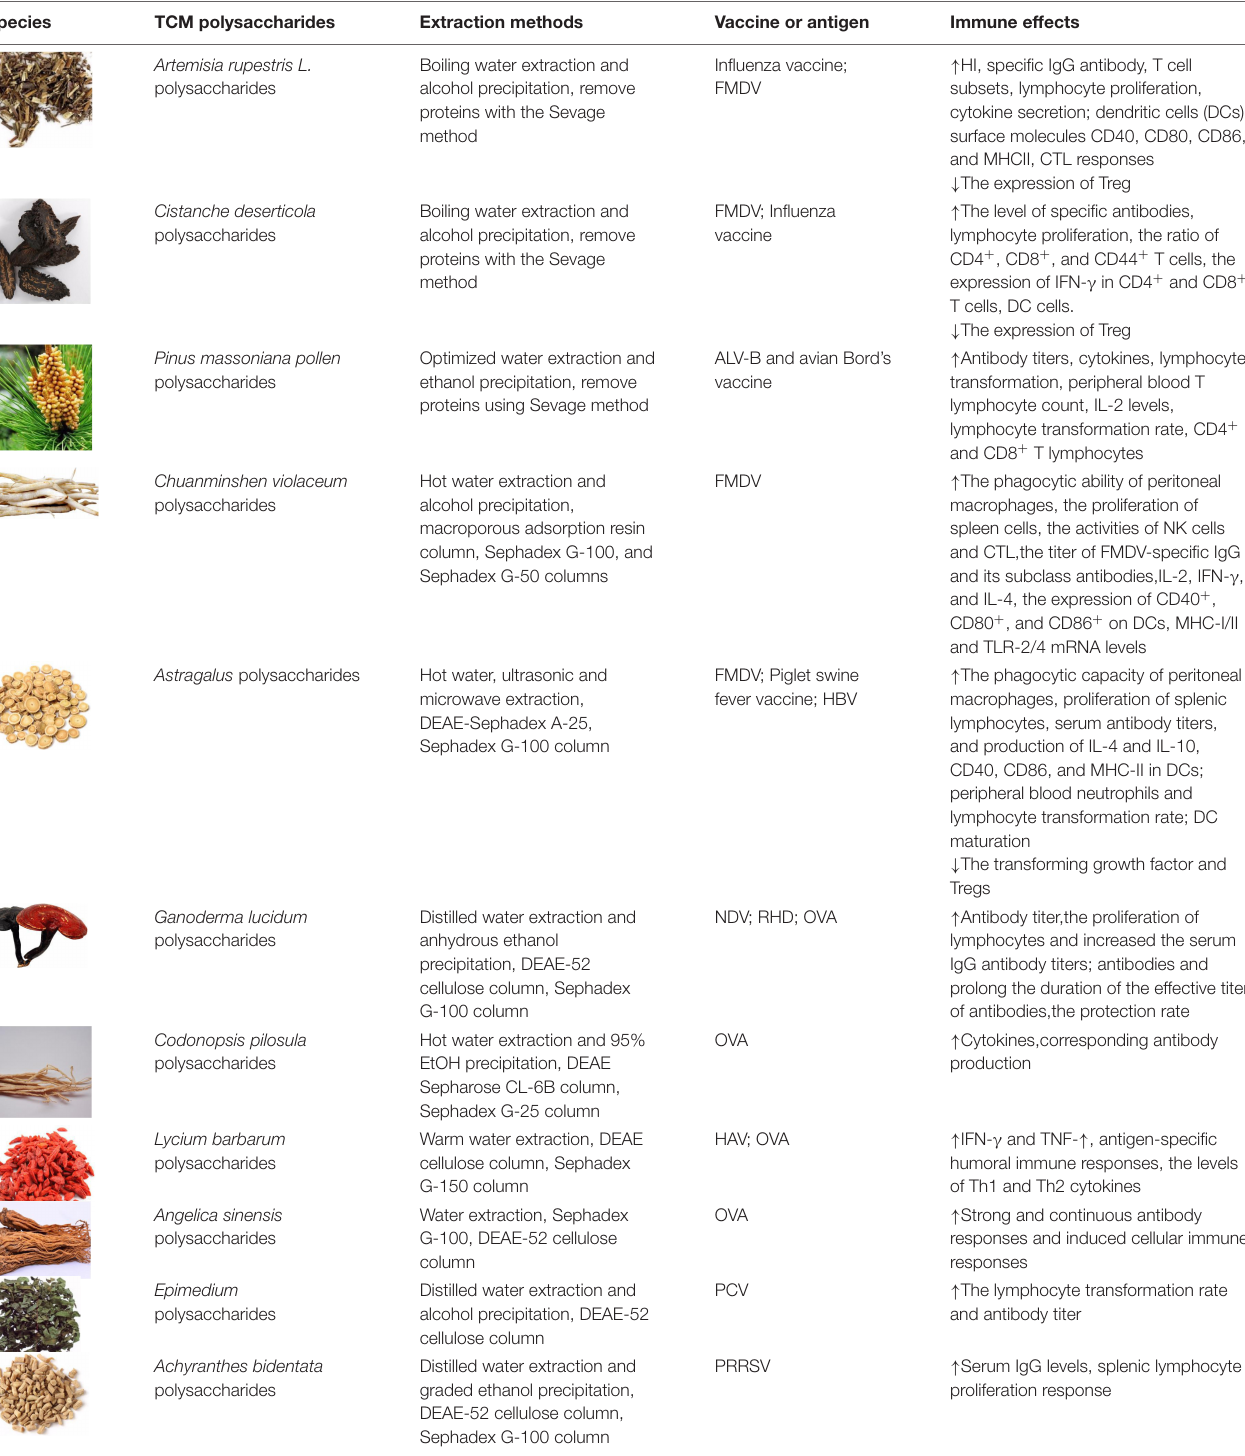
TABLE 1 | Adjuvant effects and immunoregulatory activities of TCM polysaccharides.